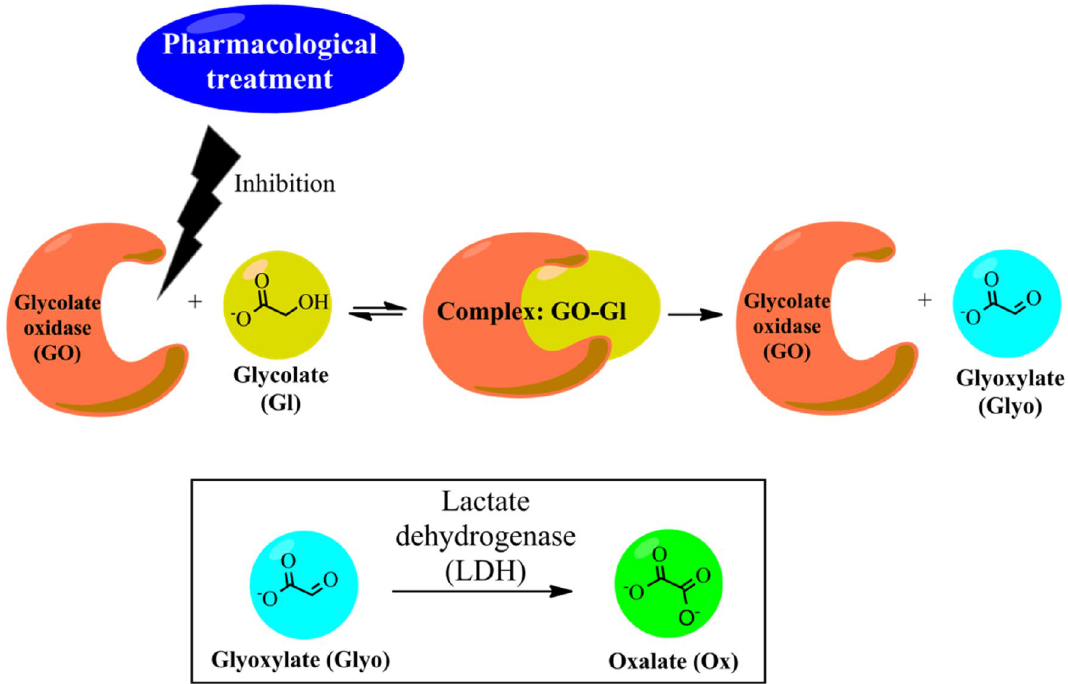
Figure 1. Schematic representation of the production of oxalate from glycolate. Detail flow: A pharmacological treatment that inhibit GO and GI interaction may reduce the production of Ox that forms insoluble kidney